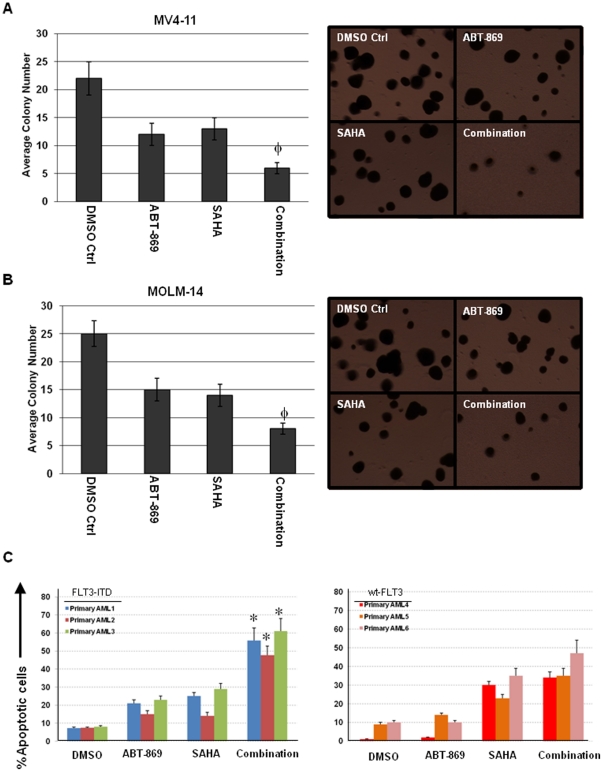
Combination treatment enhances loss of clonogenic survival and apoptosis of AML cells.(A) MV4-11 cells were treated with DMSO control, ABT-869 3 nM, SAHA 2 µM for 48 hours. (B) MOLM-14 cells were treated with DMSO control, ABT-869 6 nM, SAHA 2 µM for 48 hours. In both (A) and (B), cells were washed and plated in HSC-CFU media for 7 days. Representative pictures were presented in the right panel. The colony number was expressed as mean ± SD of average of 5 random 40 times fields. φp<0.01 as compared to single drug treatment. (C) Primary AML cells with FLT3-ITD mutation (left panel) or wt-FLT3 (right panel) were incubated with DMSO, ABT-869 20 nM, SAHA 4 µM and combination for 48 hours, followed by FACS analysis of apoptosis. The bar graphs show percentage of apoptotic cells. The experiments were duplicated. *p<0.001 as compared to single drug treatment in all the three primary AML patient samples with FLT3-ITD mutation.